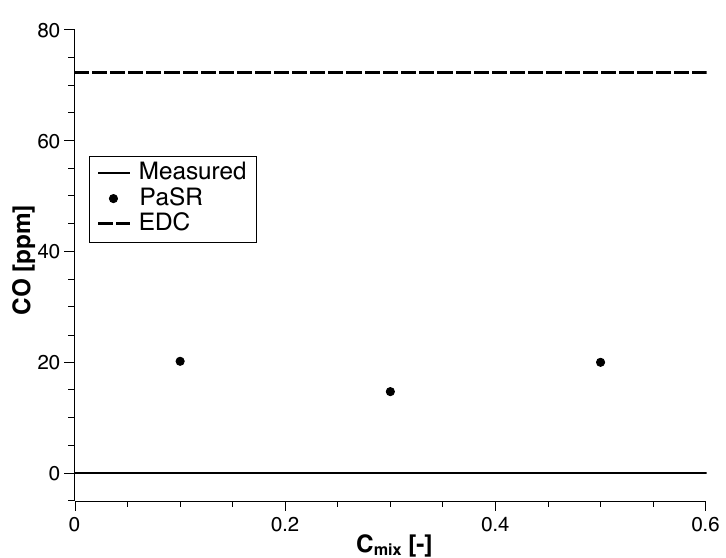
Figure 24. Comparison between the CO (ppm) measured, the ones predicted with the EDC model and the ones predicted with the PaSR combustion model for different values of C mix . λ = 2.55. Air inlet temperature 700 ◦